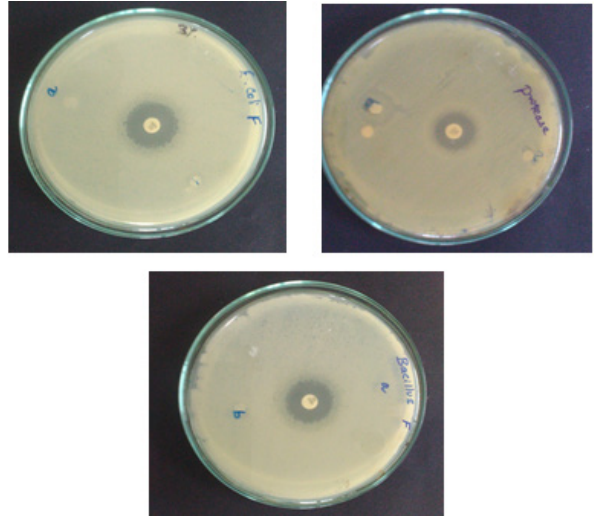
Figure 9: Antibacterial activity of ZnO NPs.